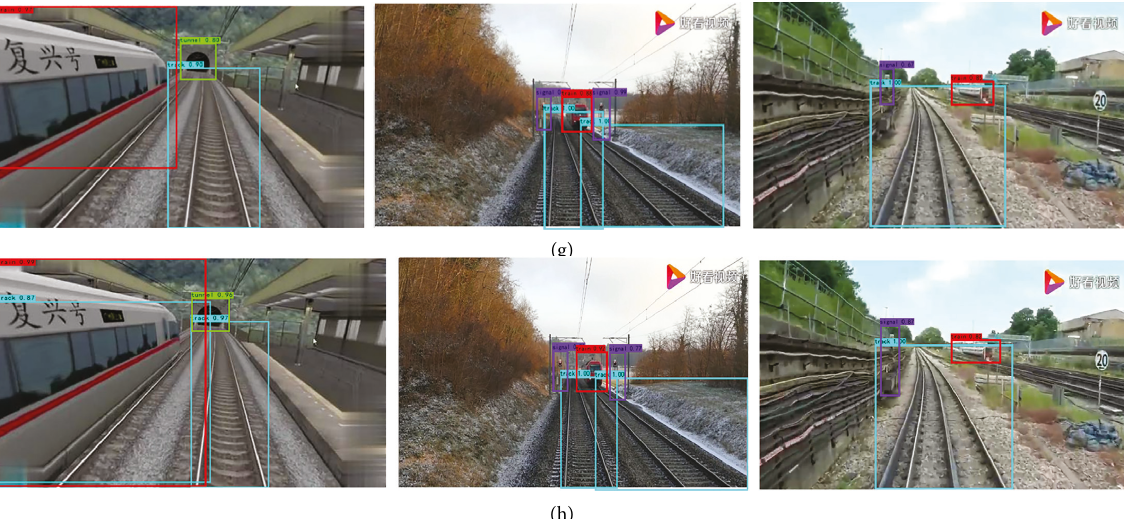
Figure 12: Comparison of the effects of object detection algorithms. (a) Original image. (b) Faster R–CNN. (c) SSD. (d) YOLO V3.